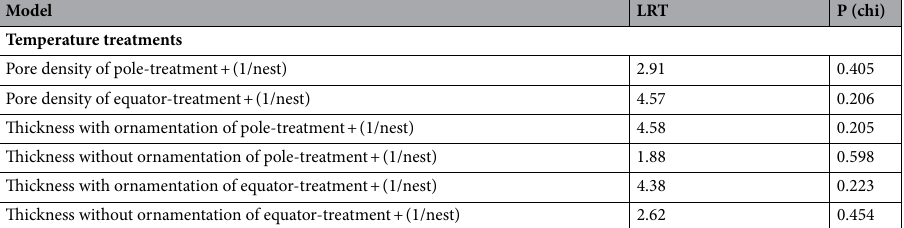
Table 1. General linear mixed models (MGLM), in which the independent variables were incubation temperature treatments, and as random variable the origin nest, and the dependent variables were: shell thickness with ornamentation (total height), thickness without ornamentation, and pore density (mean ± standard deviation). Degrees of freedom of the analyses were 3.